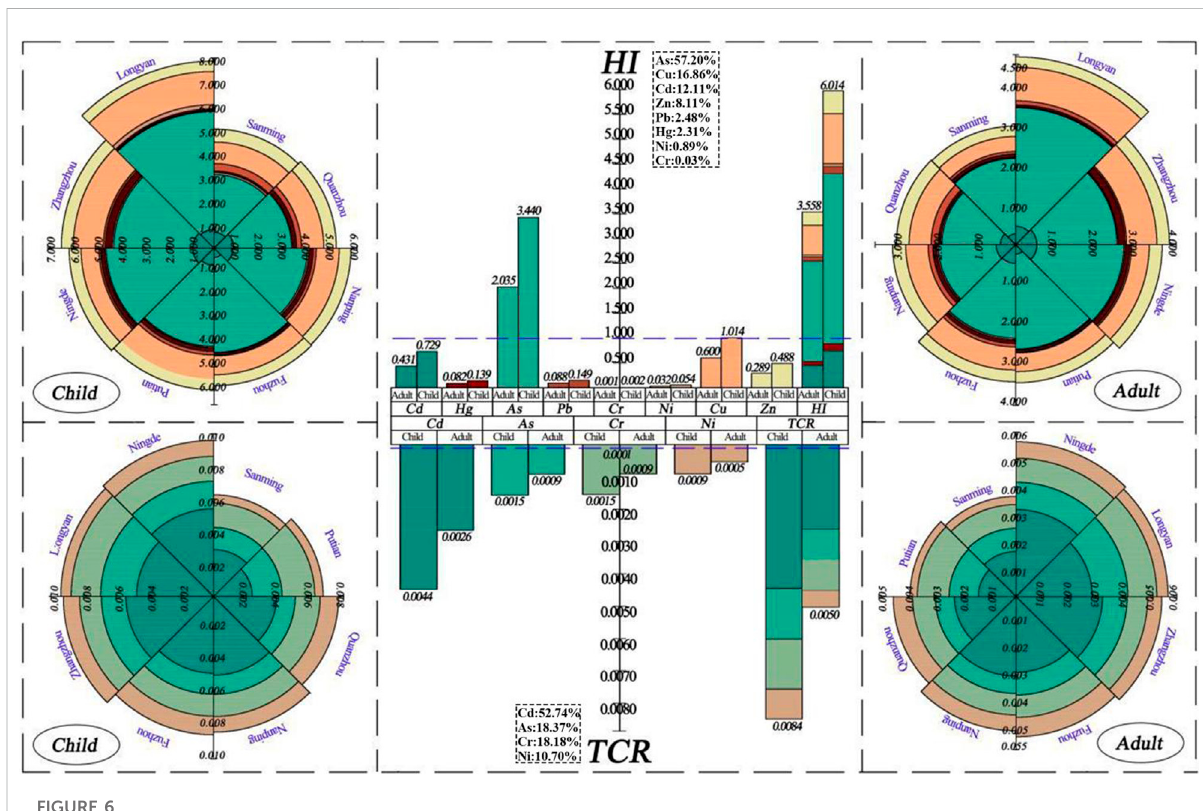
FIGURE 6 Health risk index of heavy metals in